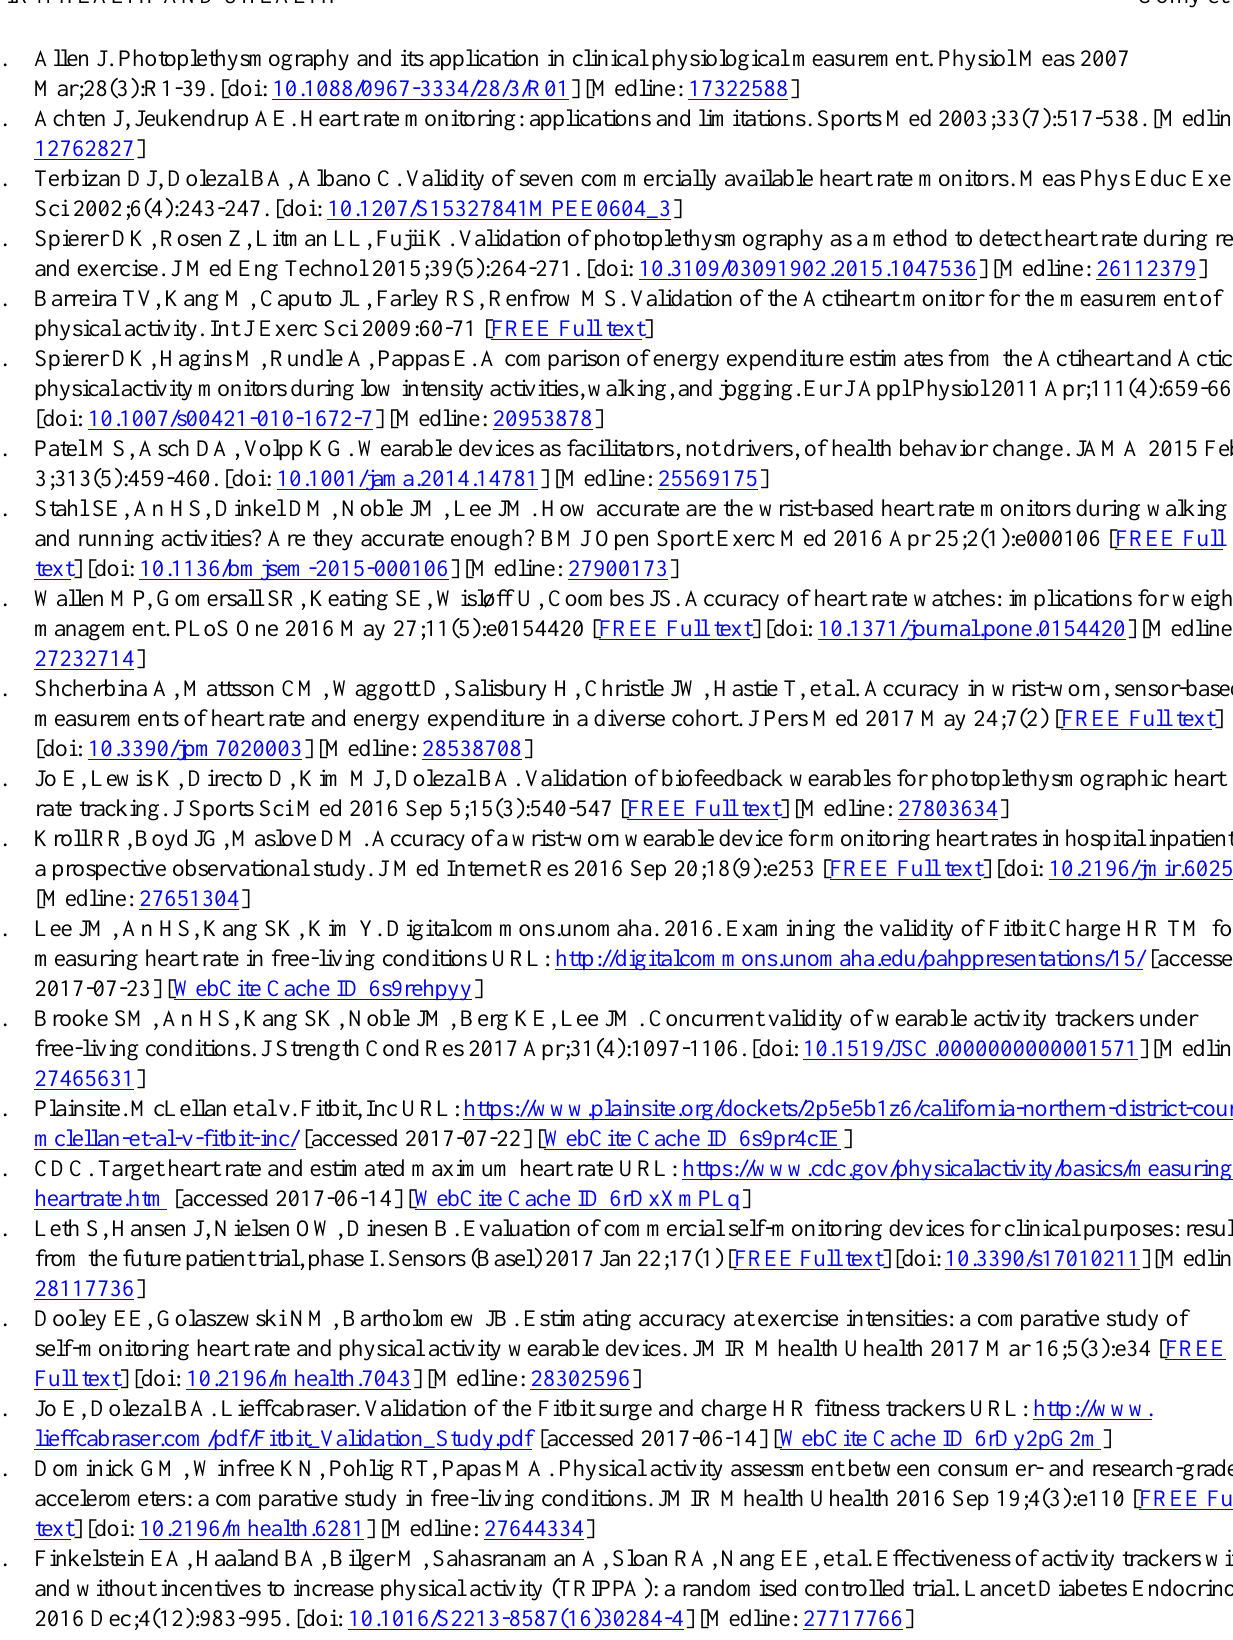
API: application programming interface CDC: Centers for Disease Control and Prevention ICC: intraclass correlation